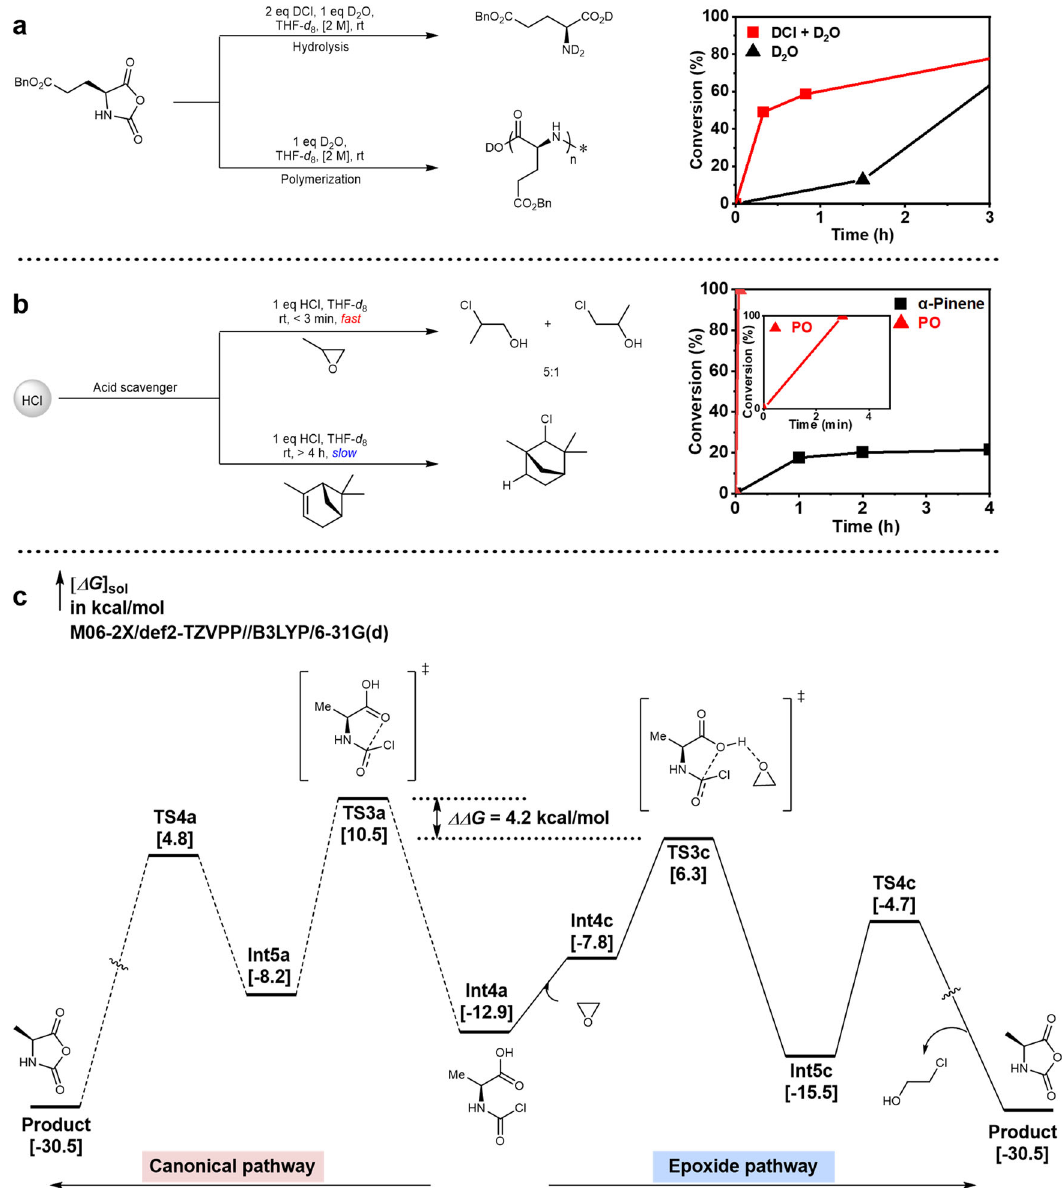
Fig. 2 Mechanistic investigations and model reactions. a Decomposition of Bn-GluNCA with D 2 O (black) or D 2 O/DCl (red). b Rate of HCl-scavenging by PO (red) or α -pinene (black) in THF- d 8 at room temperature. c DFT calculation of the ring-closure step in NCA synthesis with (right panel) or without (left panel) the assist of PO. (PO propylene